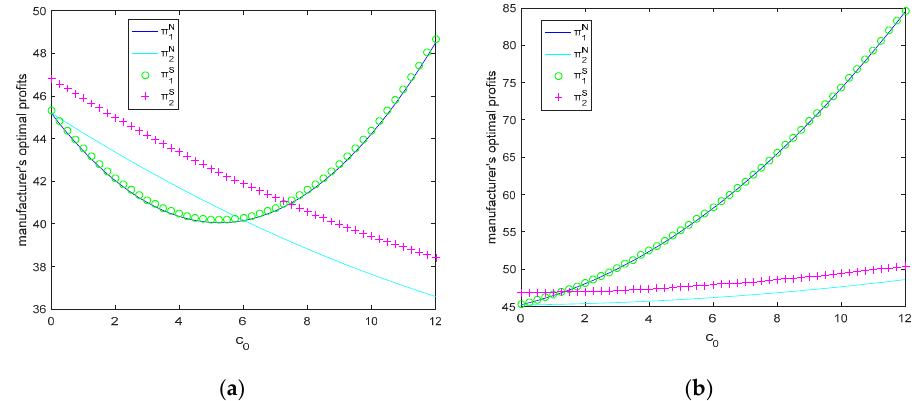
Figure 3. Manufacturer’s optimal profits as a function of c 0 when total carbon quota is ( a ) insufficient and ( b ) sufficient.